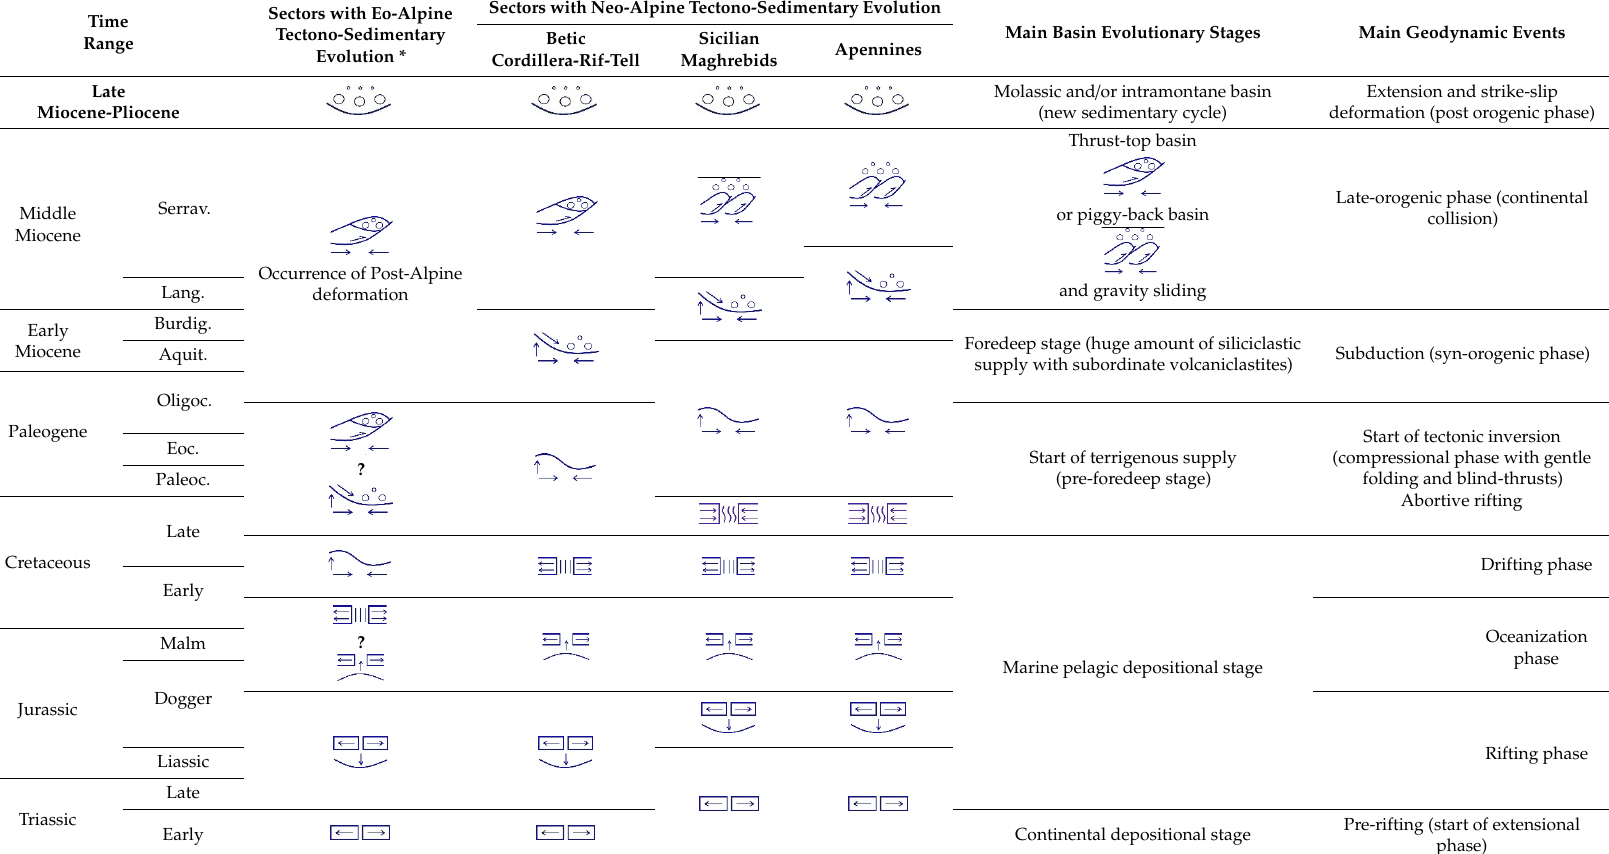
Table 1. Main geodynamic events in the eo- and neo-Alpine systems from Triassic to Pliocene recognized in different sectors of the central-western peri-Mediterranean chains (after [1,2,37,76]).